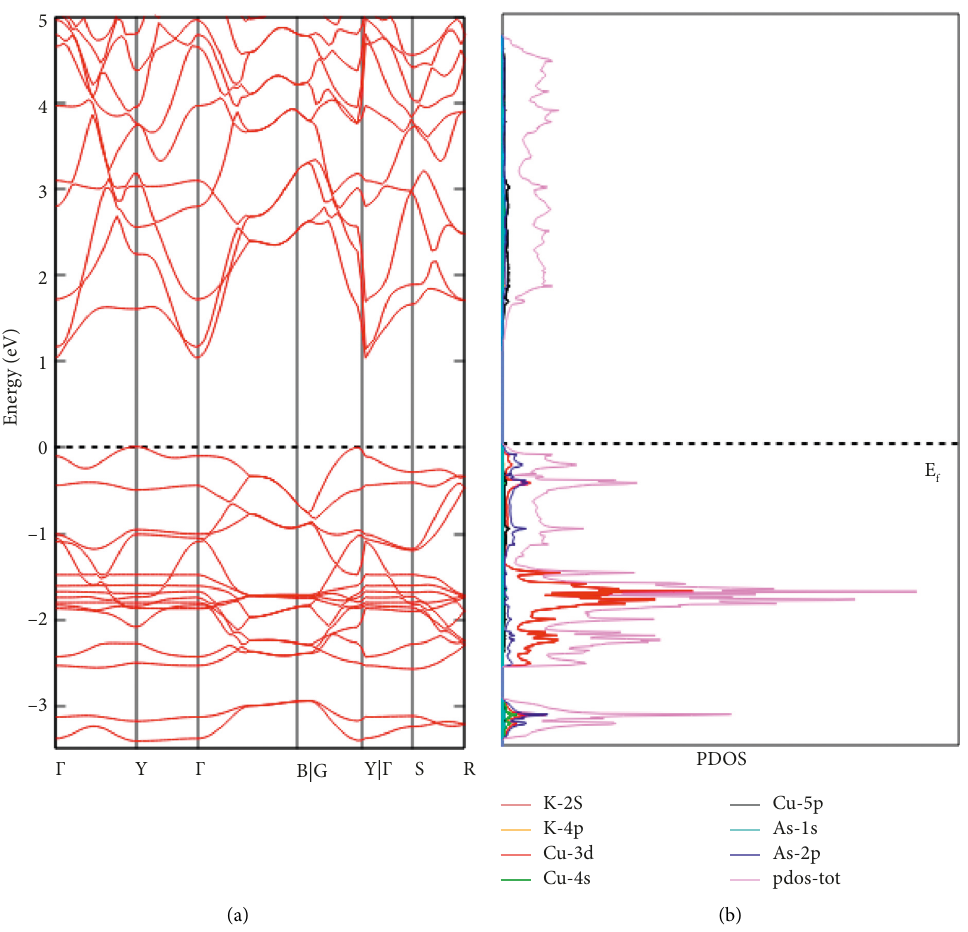
Figure 3: The calculated (a) band structure and (b) PDOS of the K